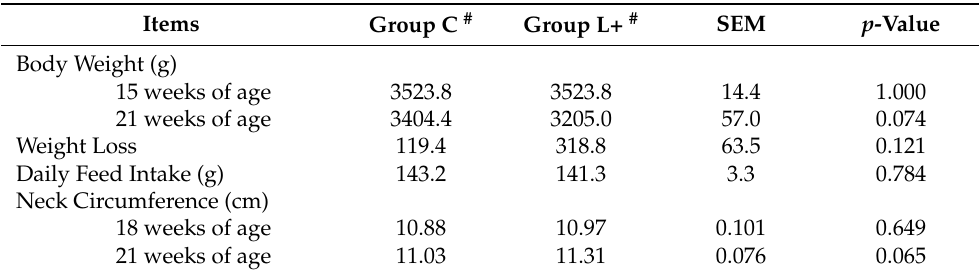
Table 1. Effects of the nocturnal 1-h lighting on the body weight, neck circumference, and feed intake in male mule ducks.